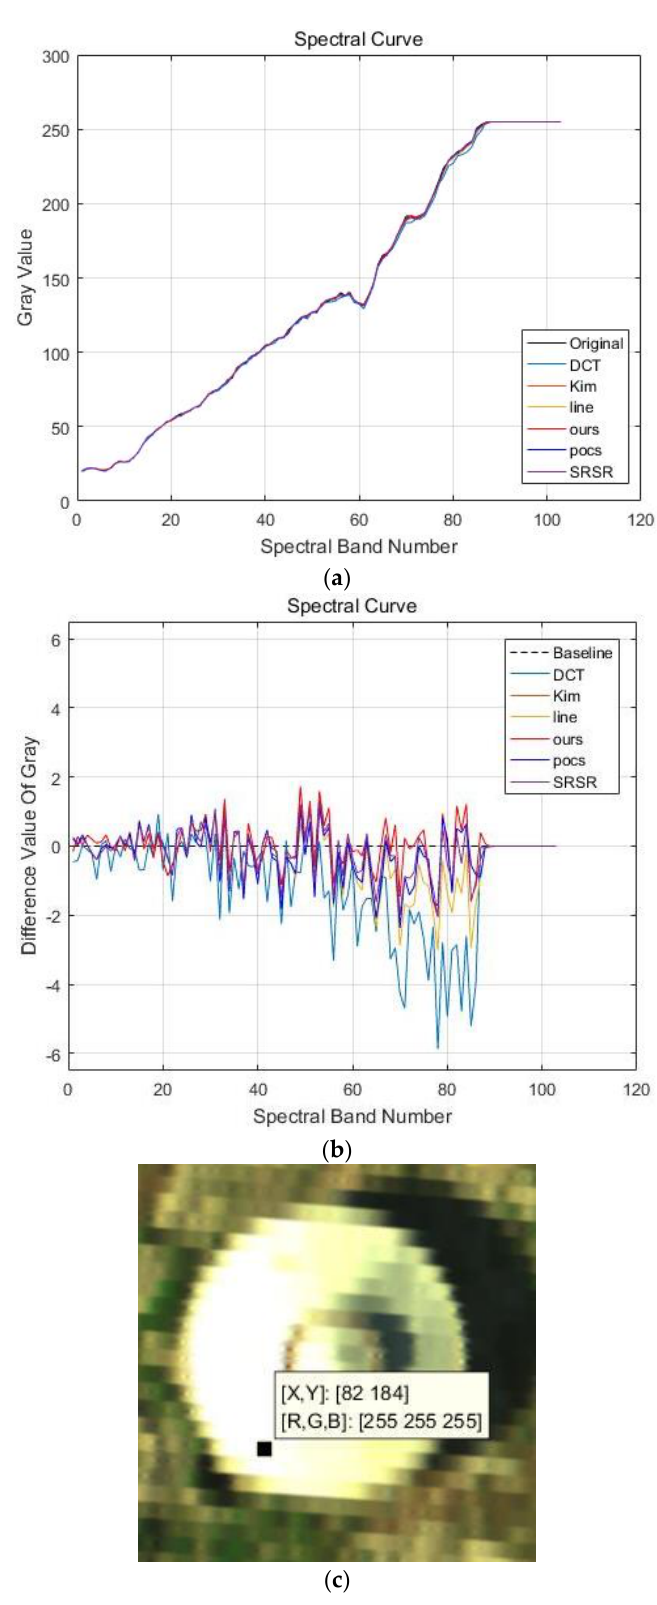
Figure 10. Spectral curves of pixel (82, 184) in the Jinyin Tan dataset 1. ( a ) Spectral curves of different methods; ( b ) Difference values of spectral curves (the black dotted line is the baseline, the red line represents the results of the proposed methods); ( c ) spectral curve location.